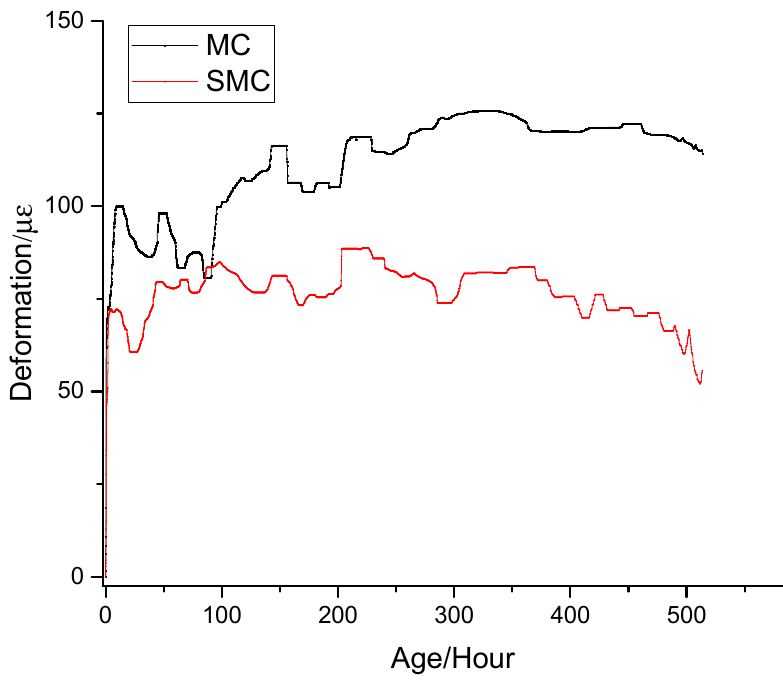
Figure 10. MgO expansion test.